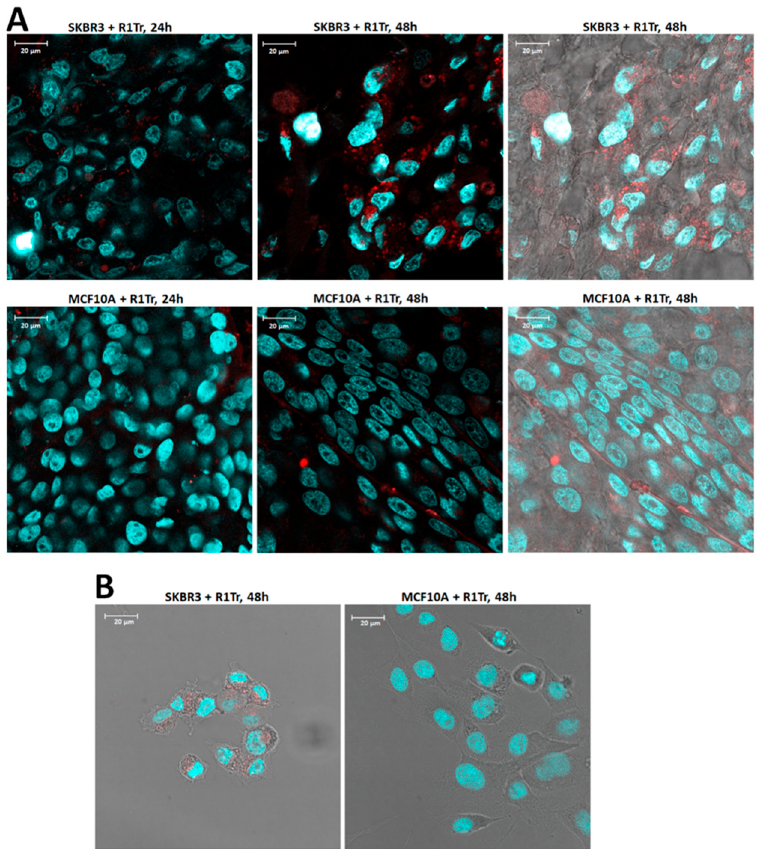
Figure 4. Panel ( A ): Images of SKBR3 spheroids (top row) and MCF10A spheroids (bottom row) incubated with truncated SKBR3-R1Tr-AF594 aptamers. Spheroids in the images on the left were incubated for 24 h with aptamers and spheroids in the middle images for 48 h. The images on the right include the bright field images of the 48 h incubations. Panel ( B ): Images of SKBR3 cells (left) and MCF10A cells (right) grown in 2D in chamber slides, incubated with truncated SKBR3-R1Tr- AF594 aptamers. Cells were incubated for 48 h with aptamers and images were acquired at 100x magnification.